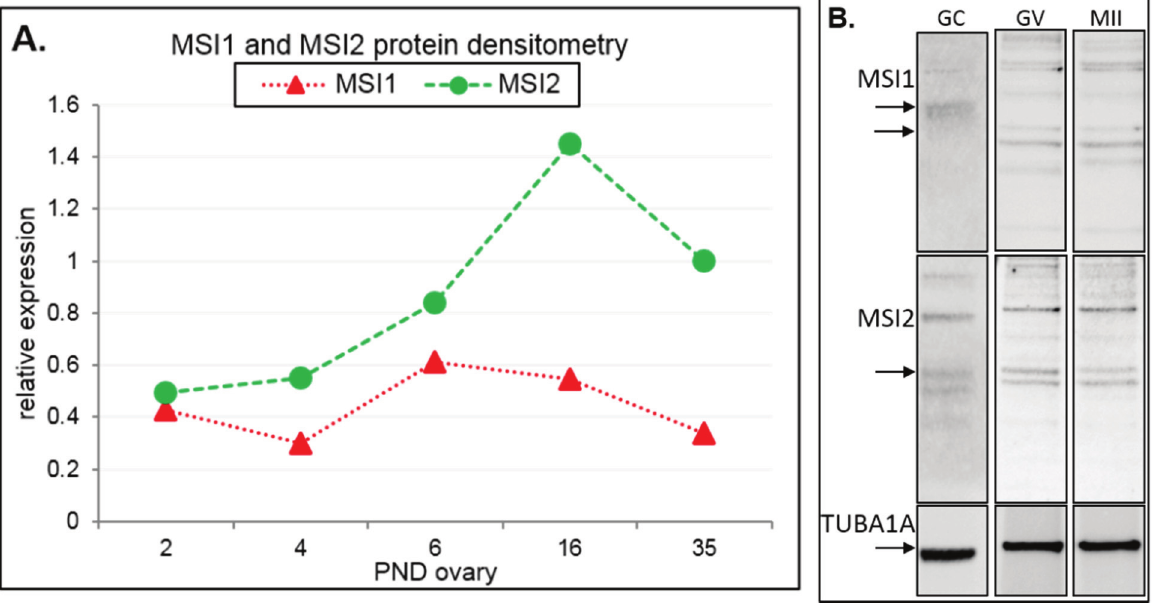
Figure 2. Immunoblot analysis of Musashi during ovary maturation . ( A ) Protein densitometry of full-length MSI1 and MSI2 in ovary time-course from post-natal day (PND) 2 through to sexual maturity at PND35. Protein expression relative to TUBA1A. For original immunoblots see Supplemental Figure S2. n = 1. ( B ) Immunoblot of MSI1 and MSI2 in isolated granulosa cells (GC), germinal vesicle oocytes (GV), and in vitro matured metaphase II oocytes (MII). Positive expression of MSI1 was detected at the appropriate size of 39 kDa for isoform 1 and 34 kDa for isoform 2 (only in oocytes). Positive expression of MSI2 was detected at ~37 kDa. Protein expression was measured relative to TUBA1A loading control at 55 kDa. For immunoblots with molecular weight marker, see Supplemental Figure